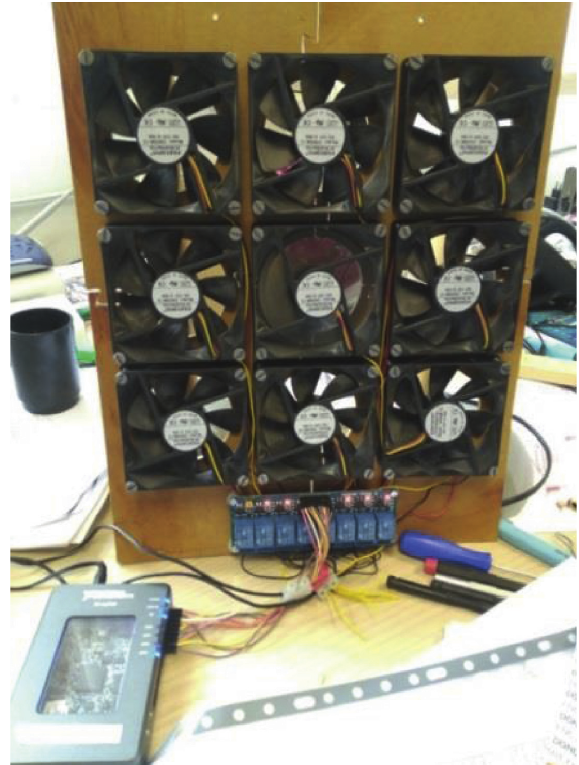
Figure 3: Test fan matrix.